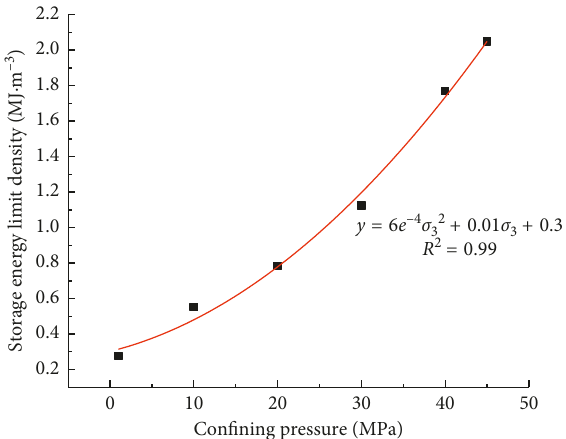
Figure 9: Energy limit density with confining pressure.